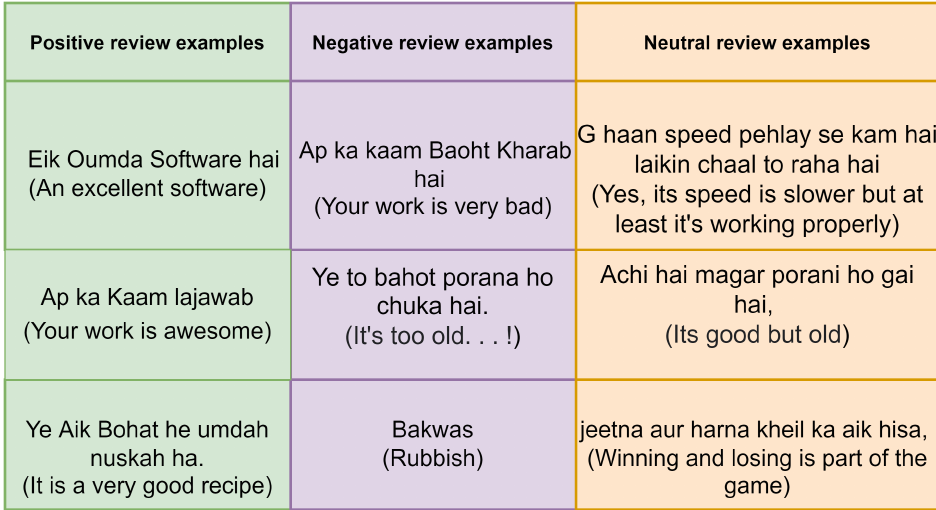
Figure 1. Examples of Roman Urdu/Hindi user reviews with English